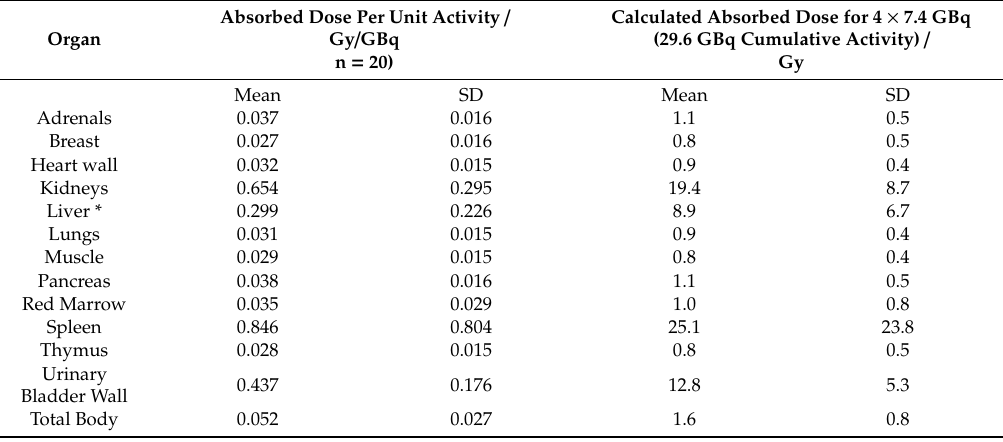
Table 1. Excerpt of estimated radiation absorbed doses for Lutathera ® in the NETTER-1 trial, adapted from